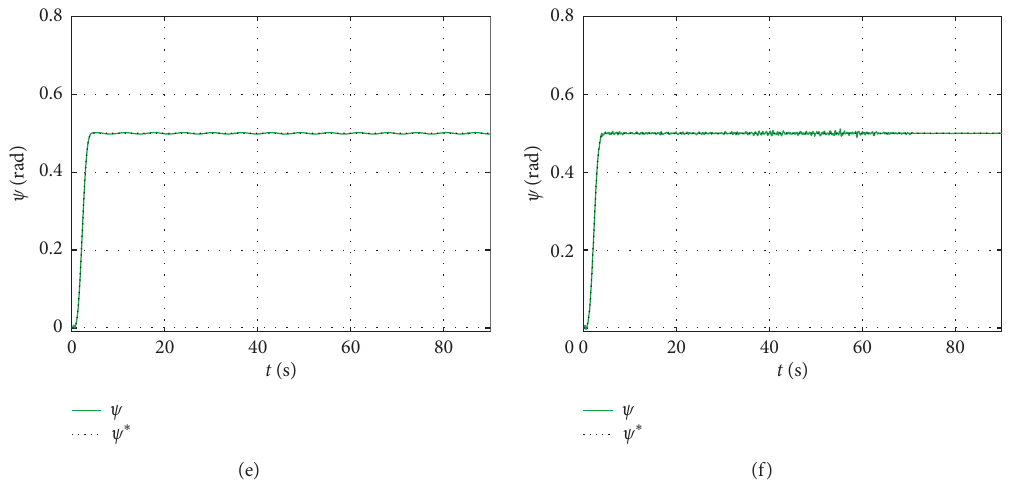
Figure 13: Tracking of planned reference trajectories for angular motion. (a) Trajectory tracking for φ , case 1. (b) Trajectory tracking for φ , case 2. (c) Trajectory tracking for θ , case 1. (d) Trajectory tracking for θ , case 2. (e) Trajectory tracking for ψ , case 1. (f) Trajectory tracking for ψ , case 2.